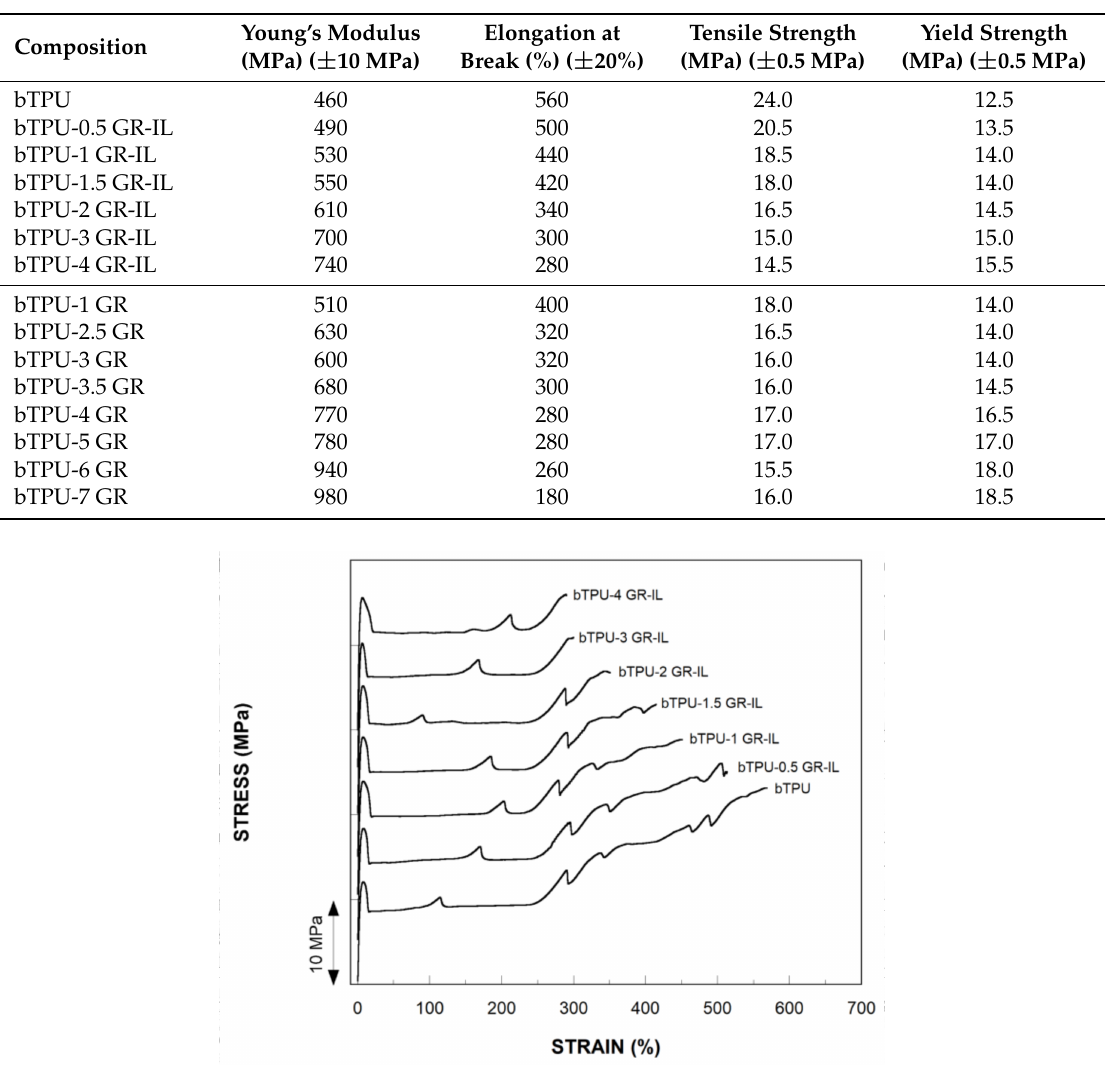
Table 2. Mechanical properties of the bTPU NCs.